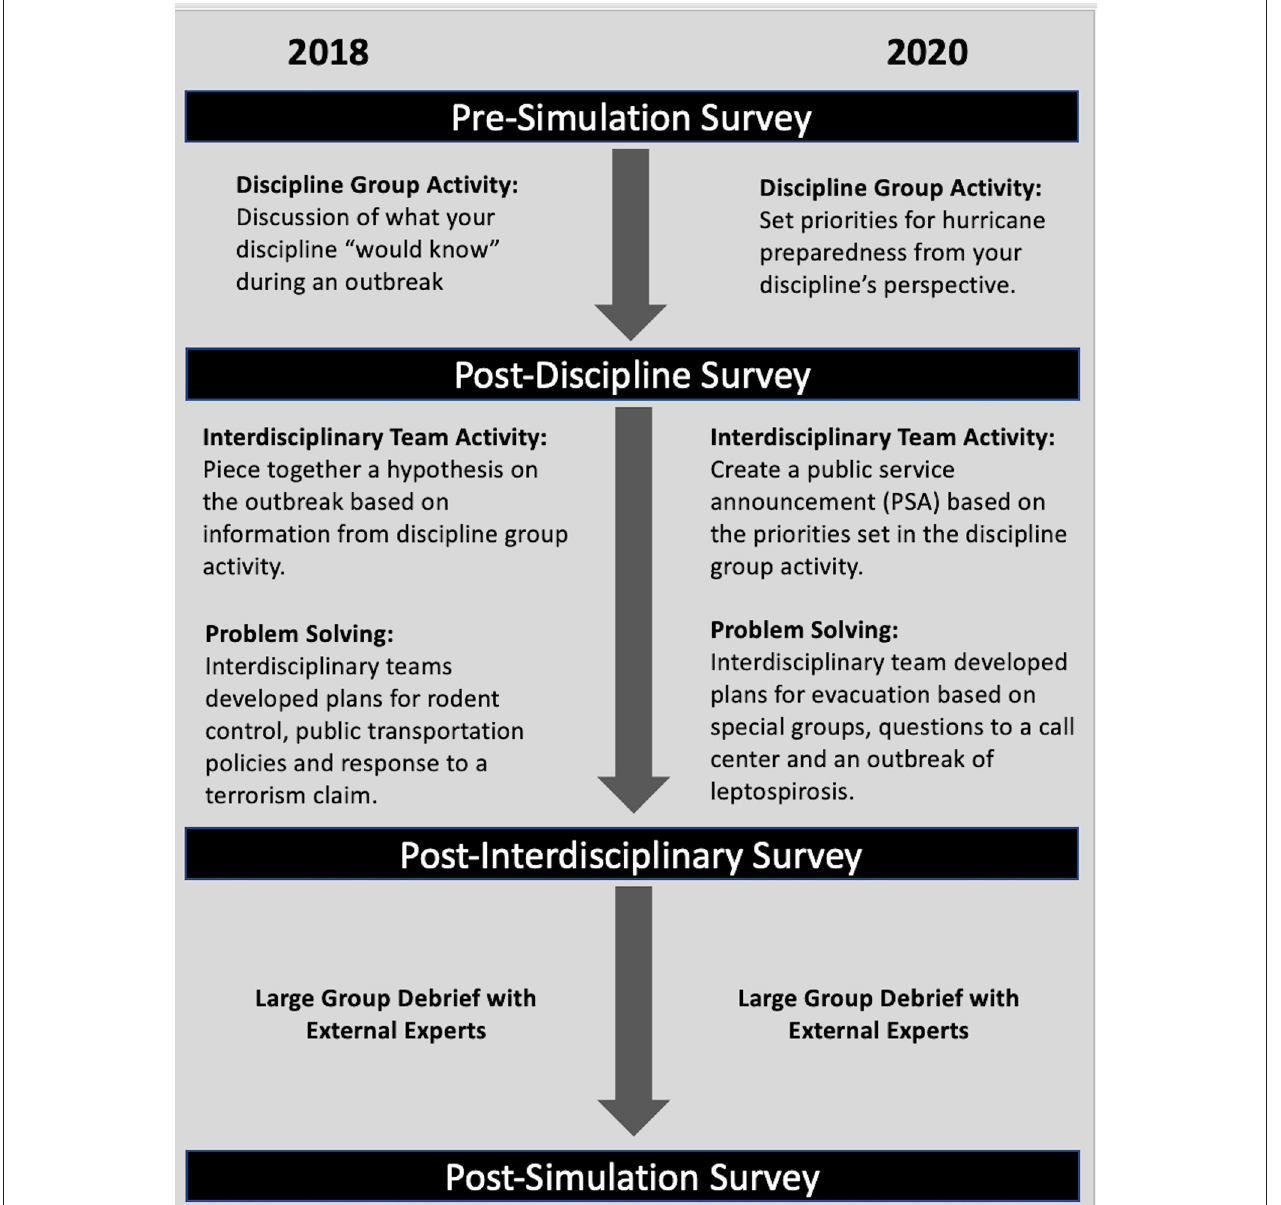
FIGURE 1 | This figure describes the PennDemic framework and the survey points described in this